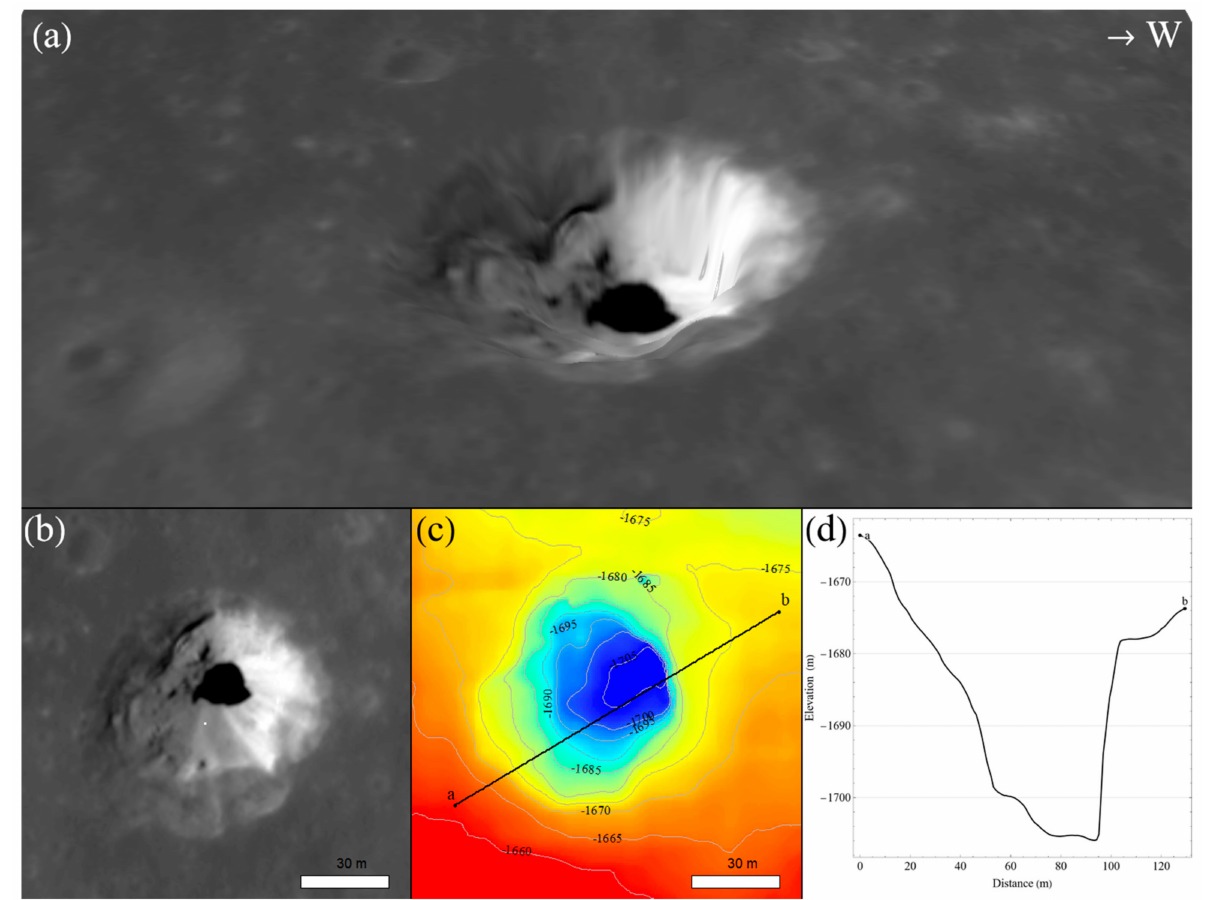
Figure 13. Pit crater (6.752 ◦ S, 42.759 ◦ E) on the west of Fecunditatis. ( a ) 3D image (real elevation values are used); ( b ) NAC orthoimage; ( c ) NAC DTM; ( d ) elevation of the profiles of ( c ). Data source: NAC M1100931431LE and NAC